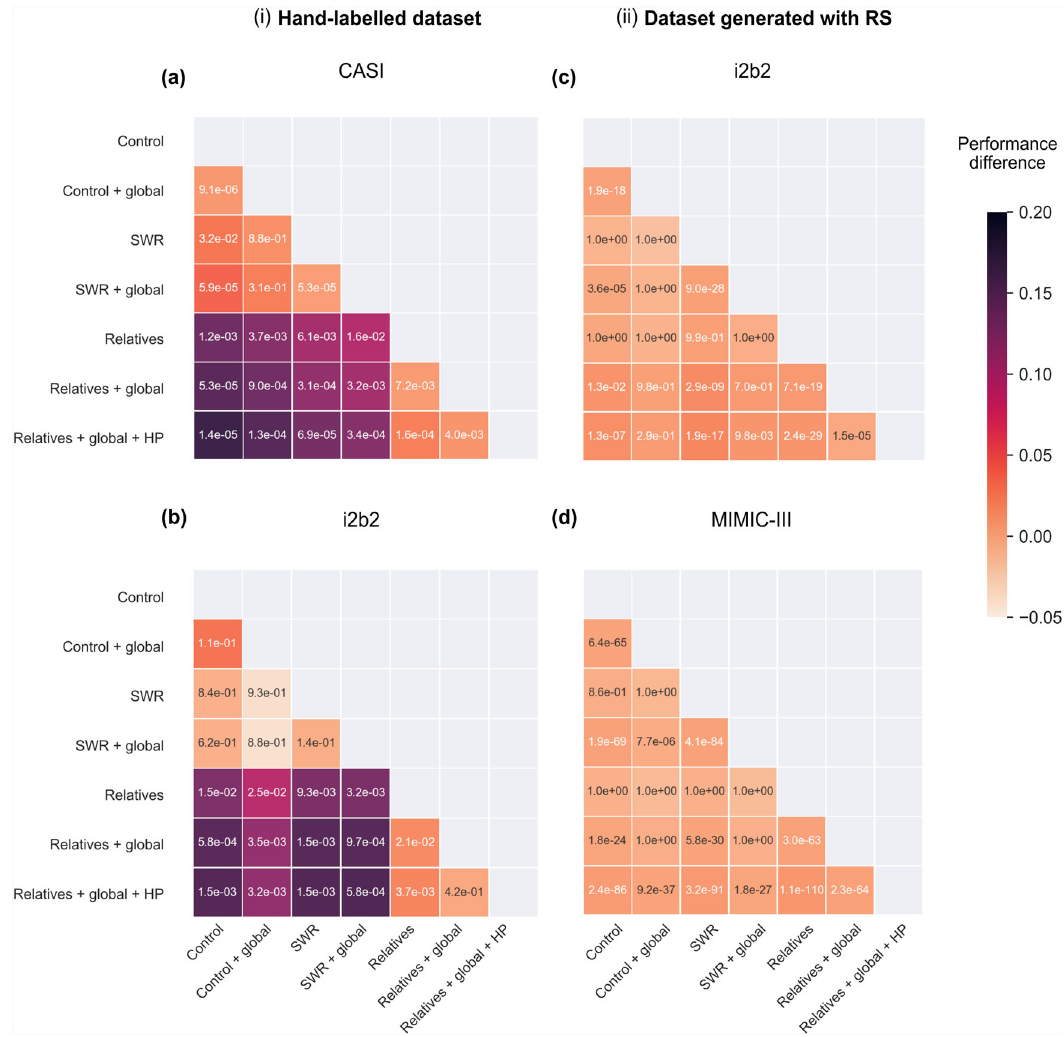
Fig. 2 Matrix showing performance differences and p-values between all models on test sets generated by (i) hand-labeling and (ii) RS. The external test sets are a CASI, b i2b2 generated by hand labeling, c i2b2 generated by RS, and d MIMIC-III generated by RS. The color intensity of each square re fl ects the performance difference between the corresponding model on the vertical axis and the model on the horizontal axis. p -Values were obtained using a one-sided Wilcoxon signed-rank test and are displayed inside each square. Note that we expect (and observe) no improvement from introducing relatives in the MIMIC-III dataset ( d ), as the default (control) algorithm better represents the underlying data distribution in